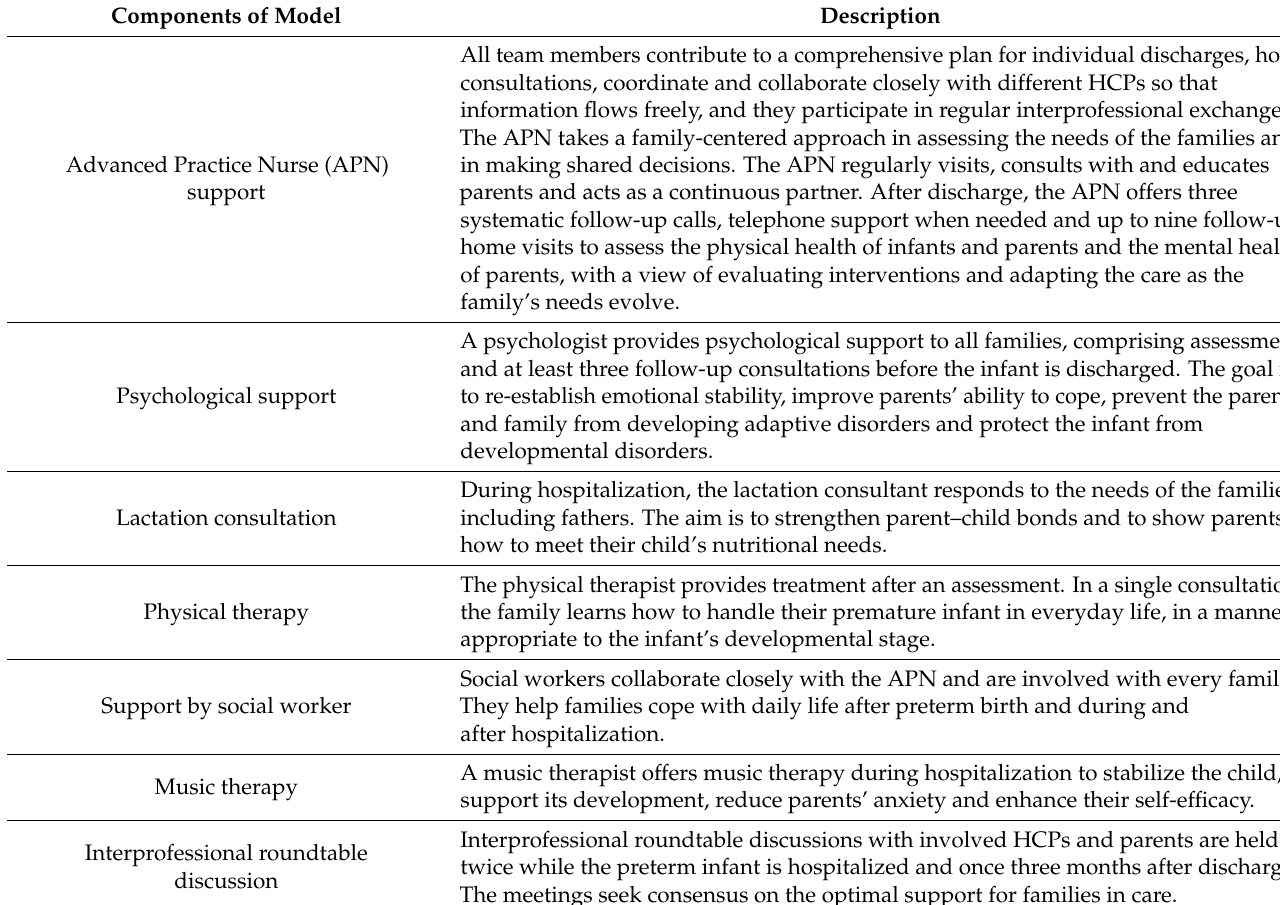
Table 1. Main Components of the Model 1 .